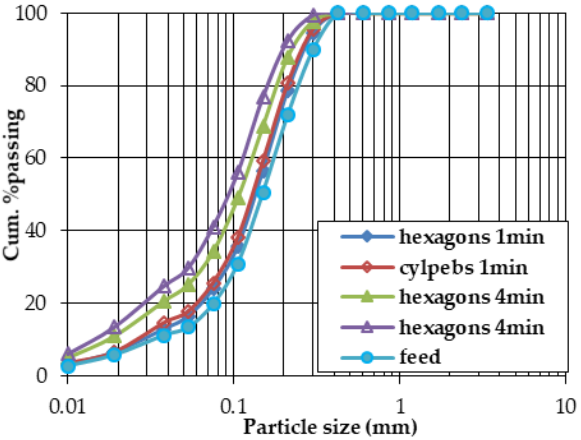
Figure 12. Size distributions of tungsten ore using hexagons and cylpebs as grinding media.